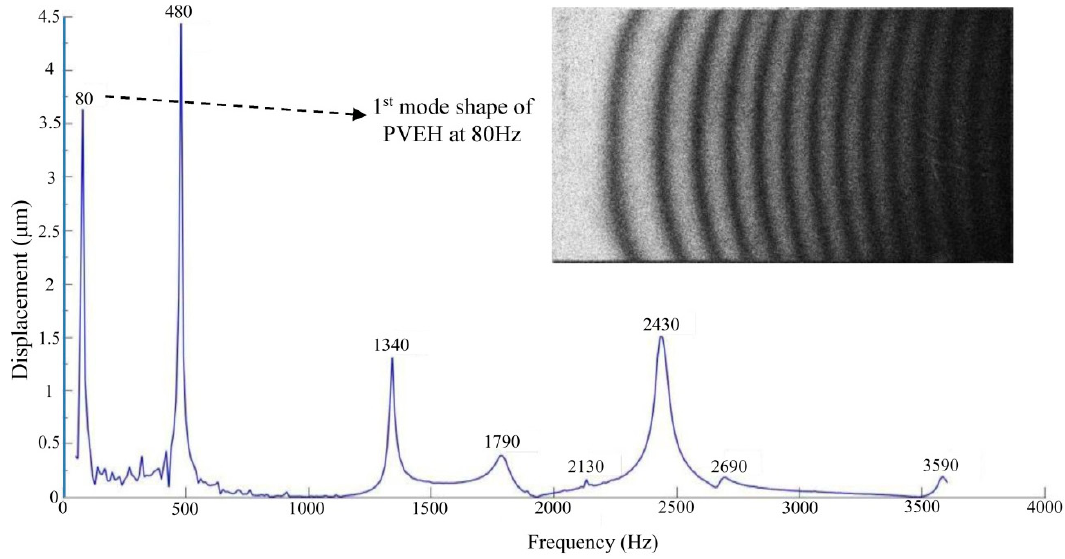
Figure 10. Dynamic characteristic of piezoelectric plate using ESPI and first bending mode contour observed at 80 Hz. Table 2. Difference between simulated and experimental